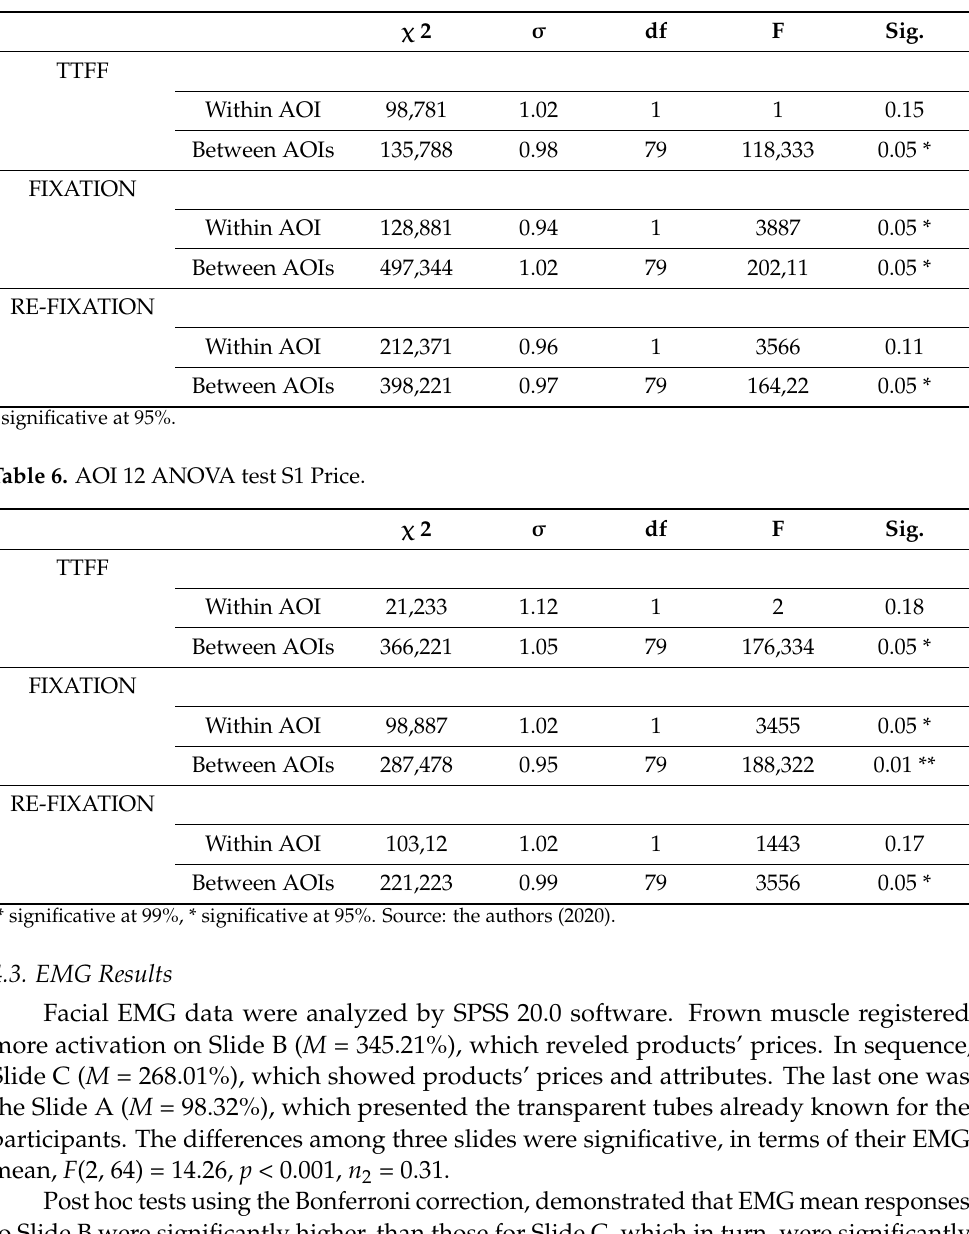
Table 5. AOI 10 ANOVA test S2 Price.